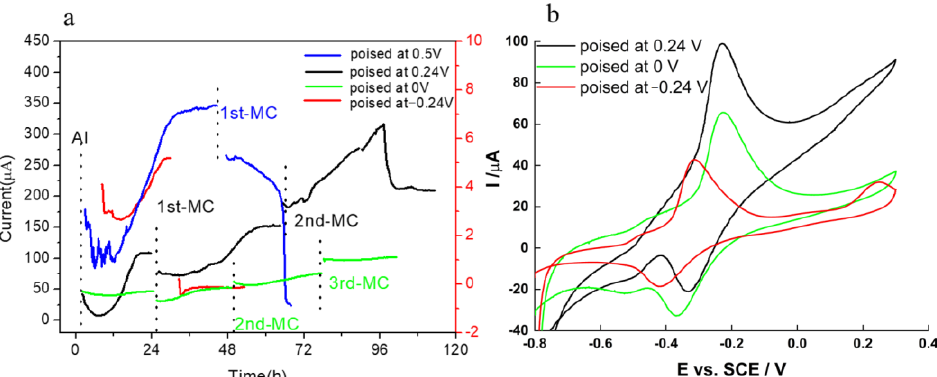
Figure 3. ( a ) CA of S. loihica PV-4 on RVC with working electrode potentials set at − 0.24, 0, 0.24 and 0.5 V vs. SCE, respectively. At − 0.24 V, the y-axis on the right was used to visualize the low current output; ( b ) CV of S. loihica PV-4 biofilm at 96 h after MC at different working electrode potentials. The CV of the experiment at 0.5 V vs. SCE did not show any peak and was not included in the figure. MC indicates the medium change, in which spent medium was replaced with fresh medium.